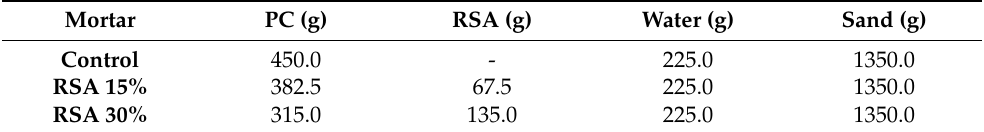
Table 1. Doses of the control and PC/RSA